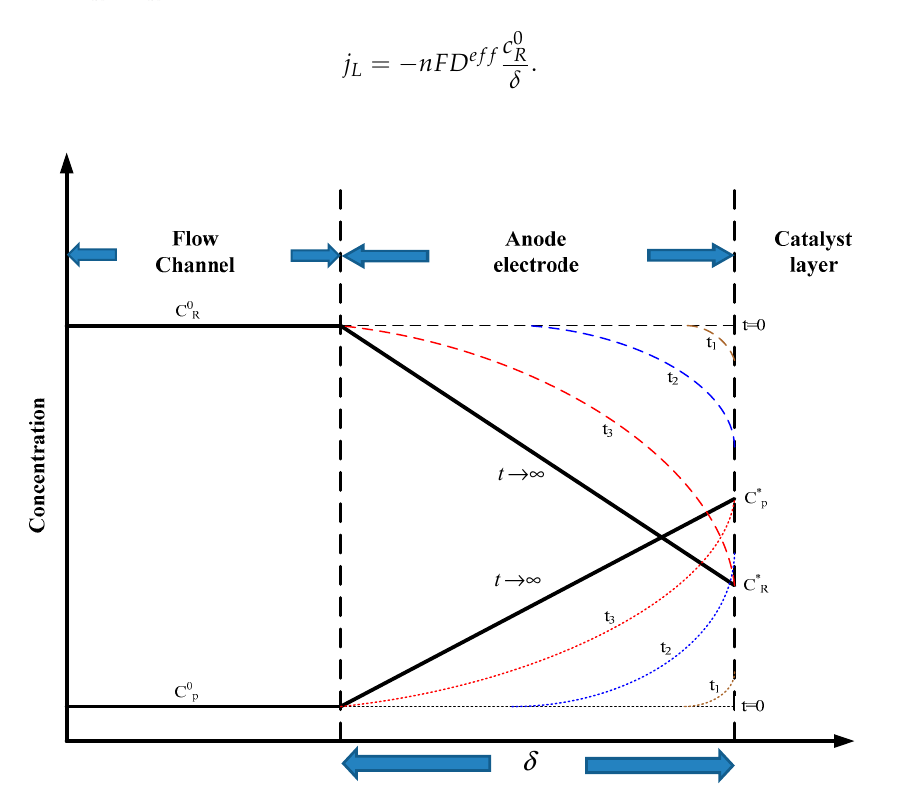
Figure 1. Schematic variation of a fuel cell reactant and product concentration according to time [15].